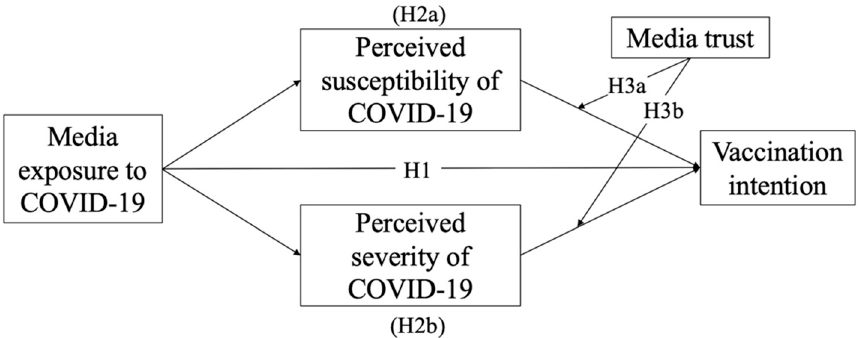
Figure 1. Proposed model of the effect of media exposure on vaccination intention based on the HBM.